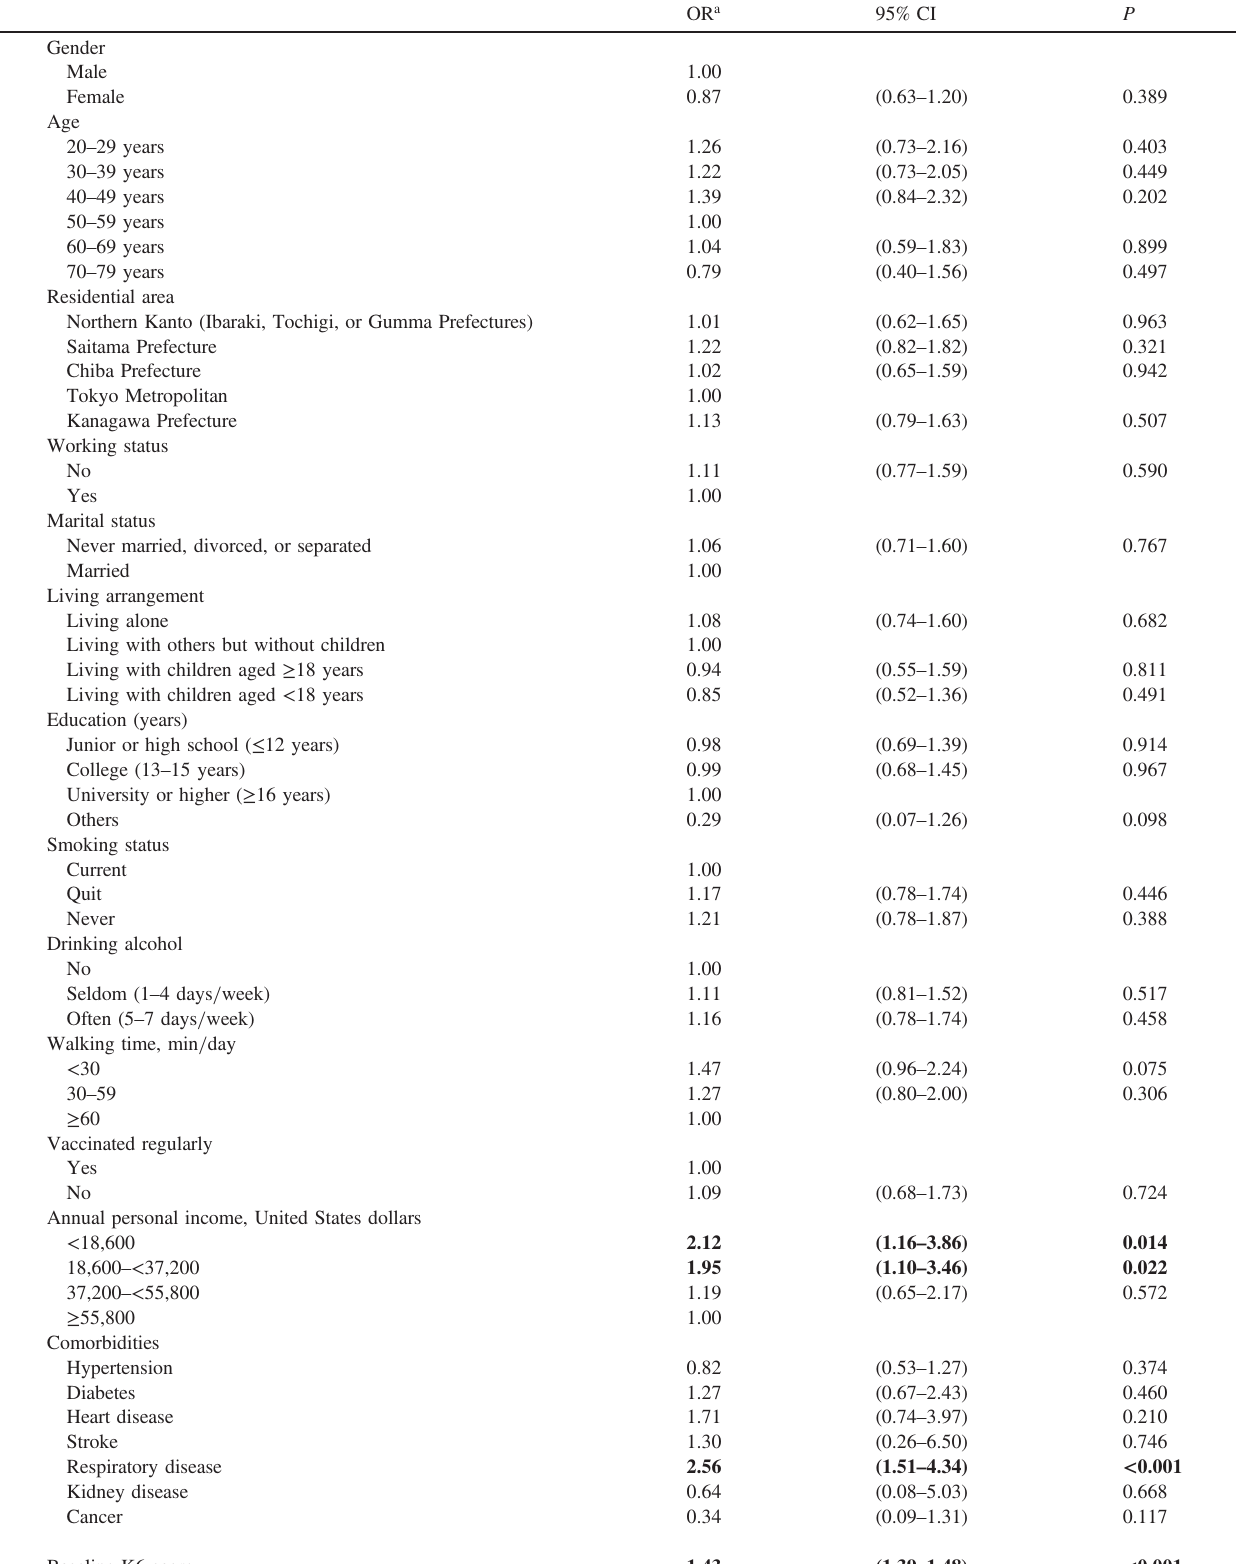
Table 2. Individual factors associated with development of severe psychological distress: mixed-e ff ect ordinal logistic regression results OR a 95% CI